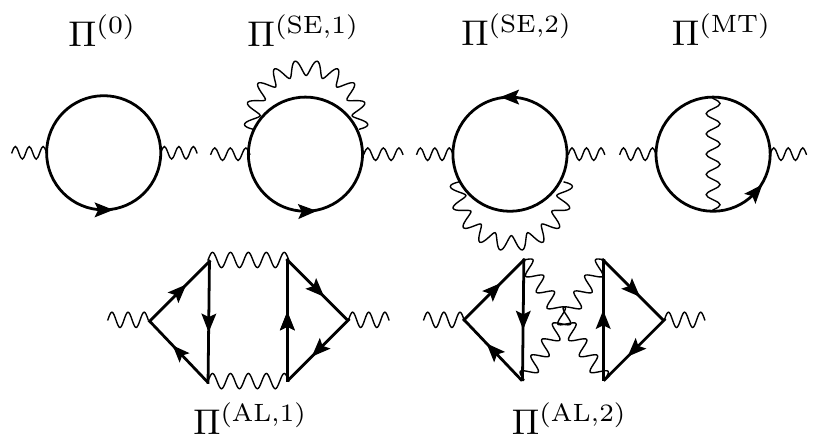
Figure 4: Diagrammatic contributions to the boson self energy, Π ( q = 0, i ν ) , to ( 1 / N ) . Π ( 0 ) is the one-loop RPA bubble. Π ( SE,1 ) , Π ( SE,2 ) , and Π ( MT ) are the f O fermion self energy corrections and the vertex correction (Maki-Thompson diagram). Π ( AL,1 ) , Π ( AL,2 ) are the Aslamasov-Larkin